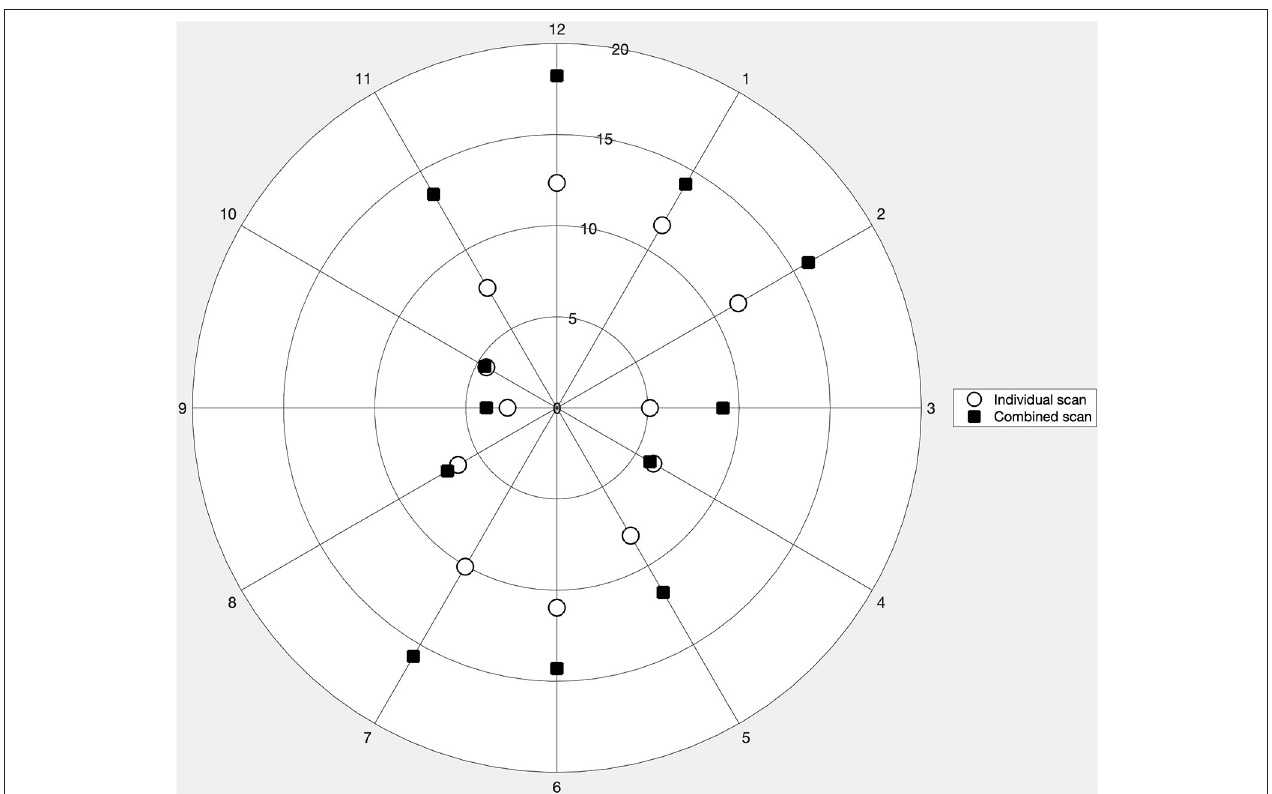
FIGURE 4 | Repeatability limit for the peripapillary retinal nerve fiber layer thickness measurements for the 12 clock sectors obtained with the individual and combined scan modes represented in a polar